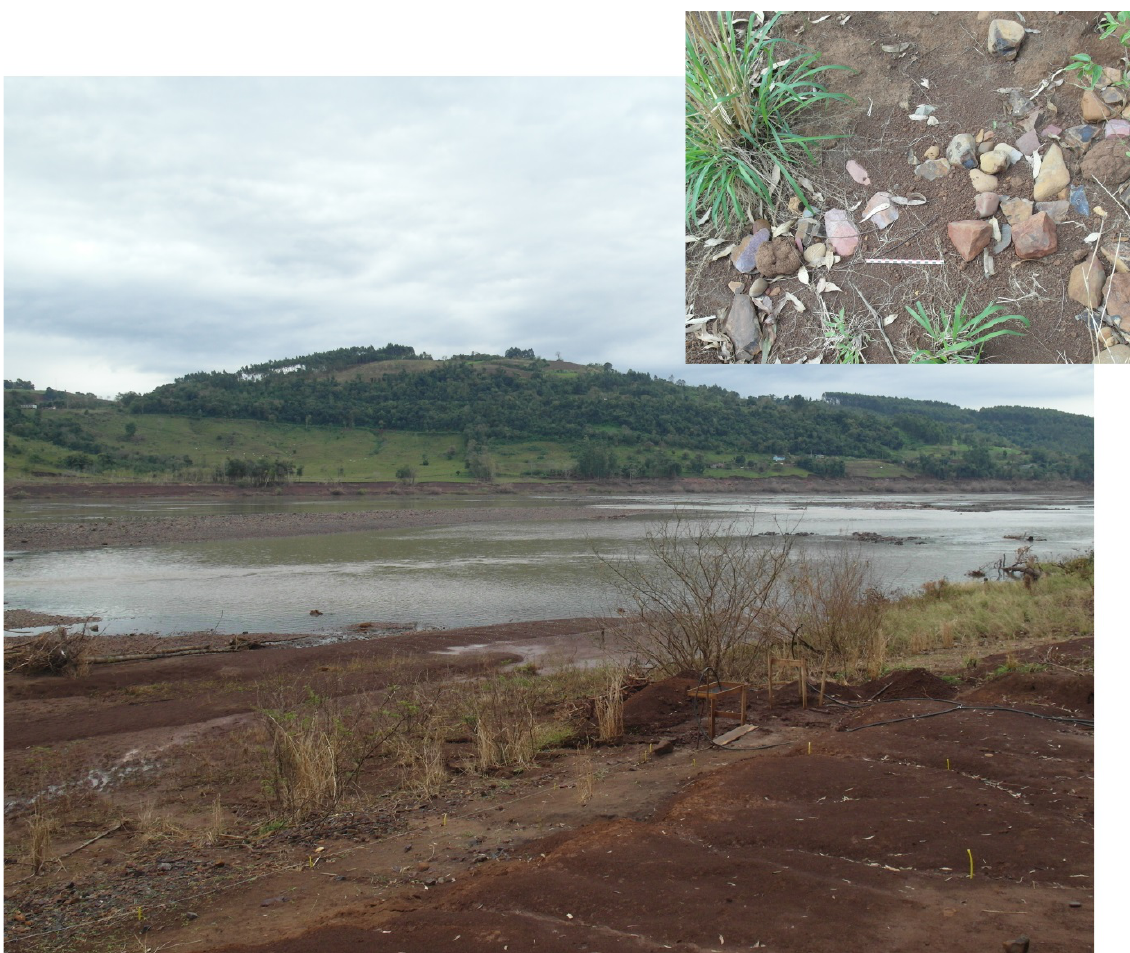
Figura 2. Vista das duas margens do rio Uruguai desde o patamar Linha Policial. No primeiro plano, vê-se ACH- LP-07. O sítio RS-URG-01 encontra-se na margem oposta do rio. Em detalhe: superfície de erosão com artefatos no sítio ACH-LP-07. Figure 2. View of the two sides of the Uruguay River from the Linha Policial platform. In the foreground, one can see ACH-LP-07. The site RS-URG-01 is in the other site of the river. In detail: erosion surface with artefacts in